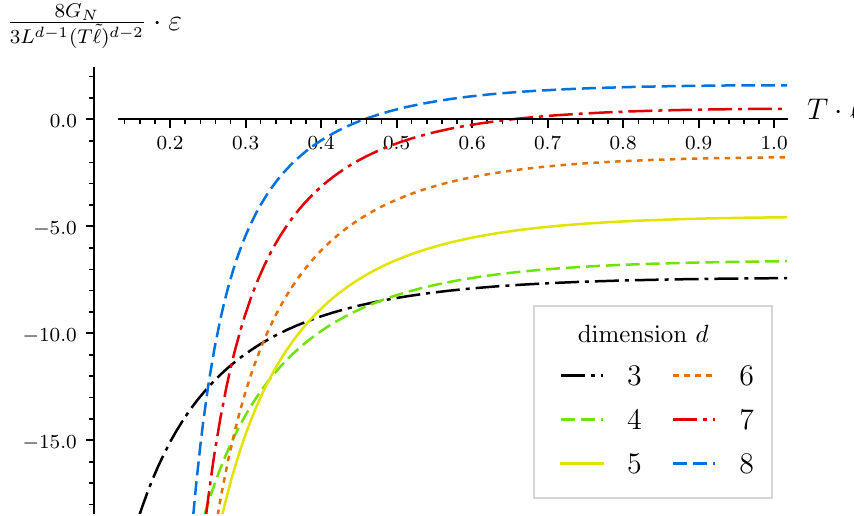
Figure 12. Cut-o(cid:11) independent part of the entanglement negativity. For plotting, we subtracted the O ( (cid:15) ) 2 (cid:0) d term. For d = 2, we subtracted 2 L ln( (cid:15)=z h ).